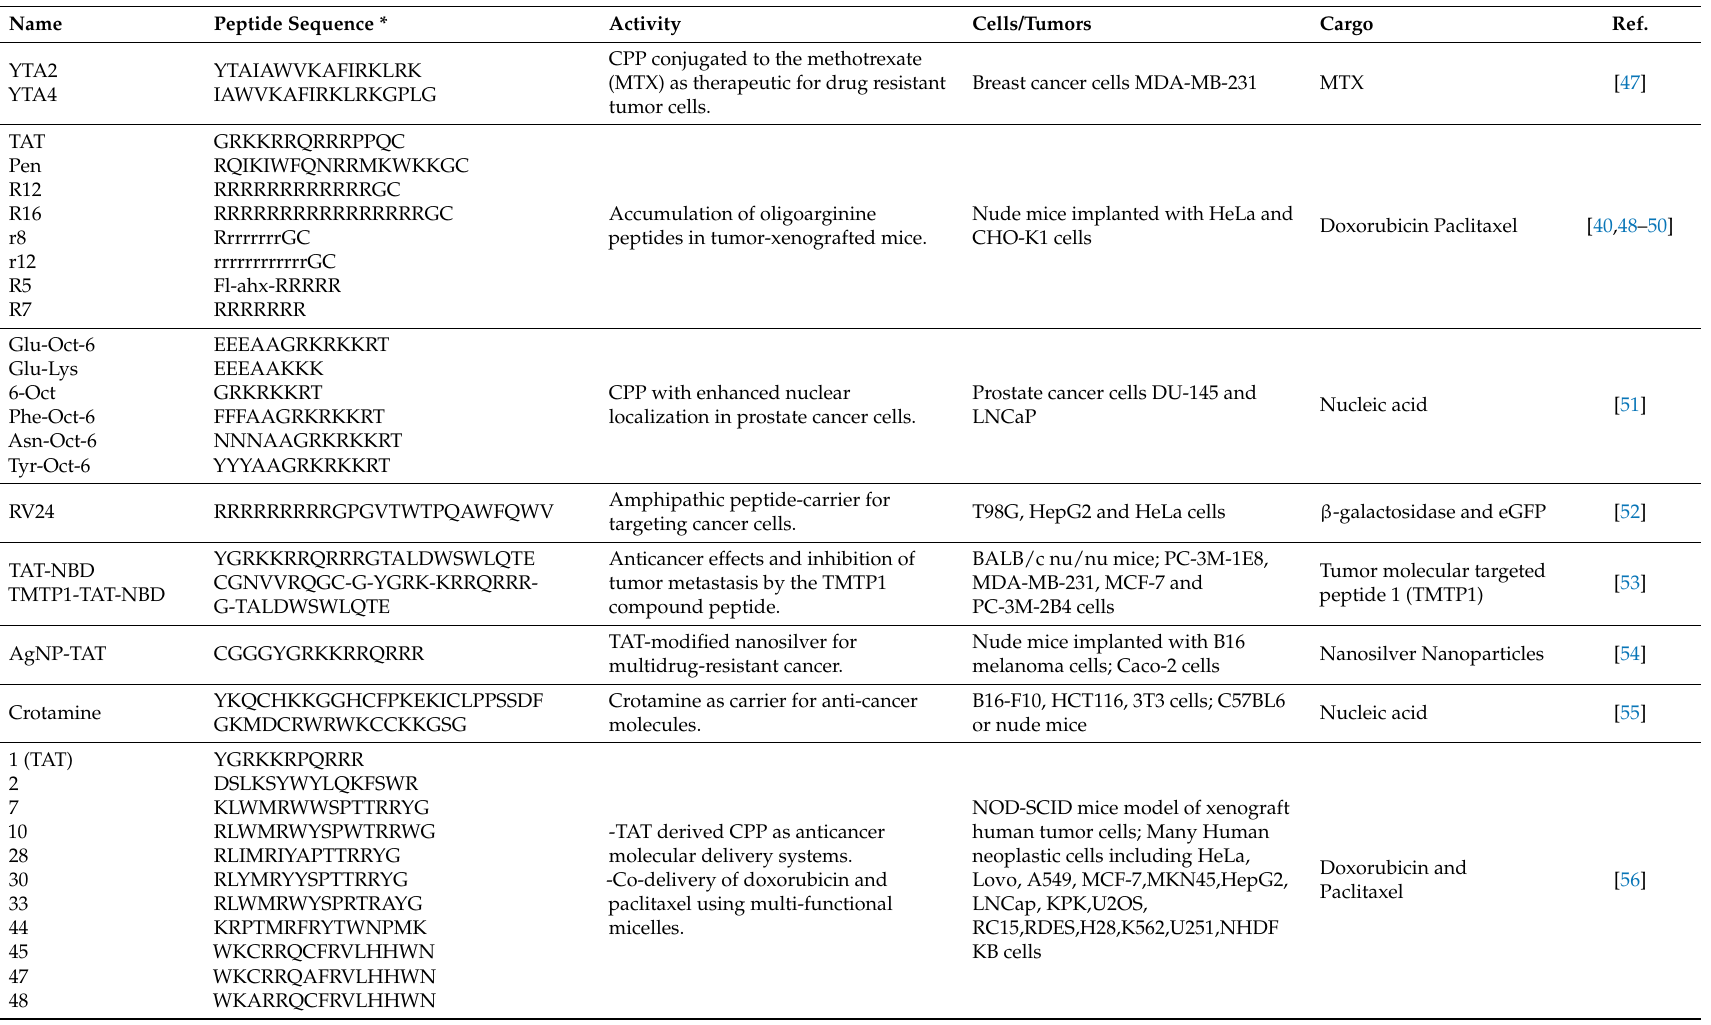
Table 1. List of CPP-derived molecules selected from CPPsite 2.0 database and from the literature for in vivo and/or in vitro anticancer